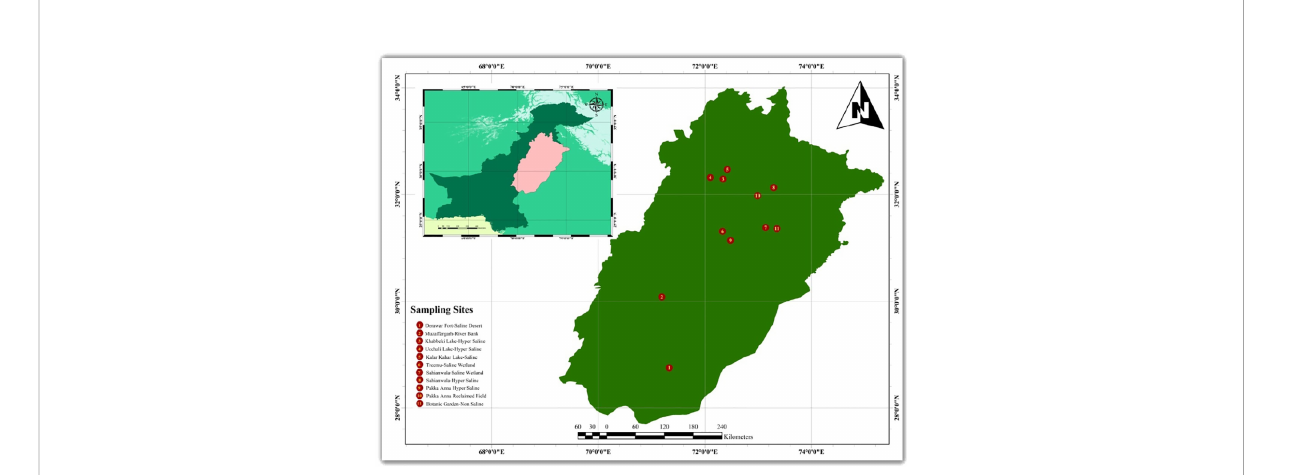
FIGURE 1 Map of the Punjab, Pakistan showing collection sites of Cynodon dactylon